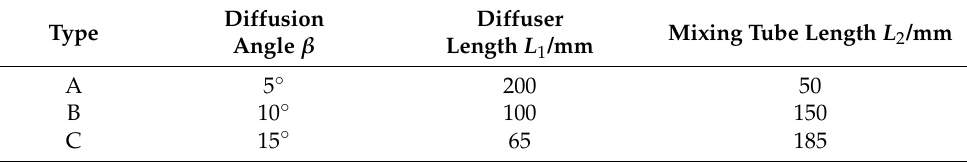
Table 3. Different diffusion angles correspond to structural